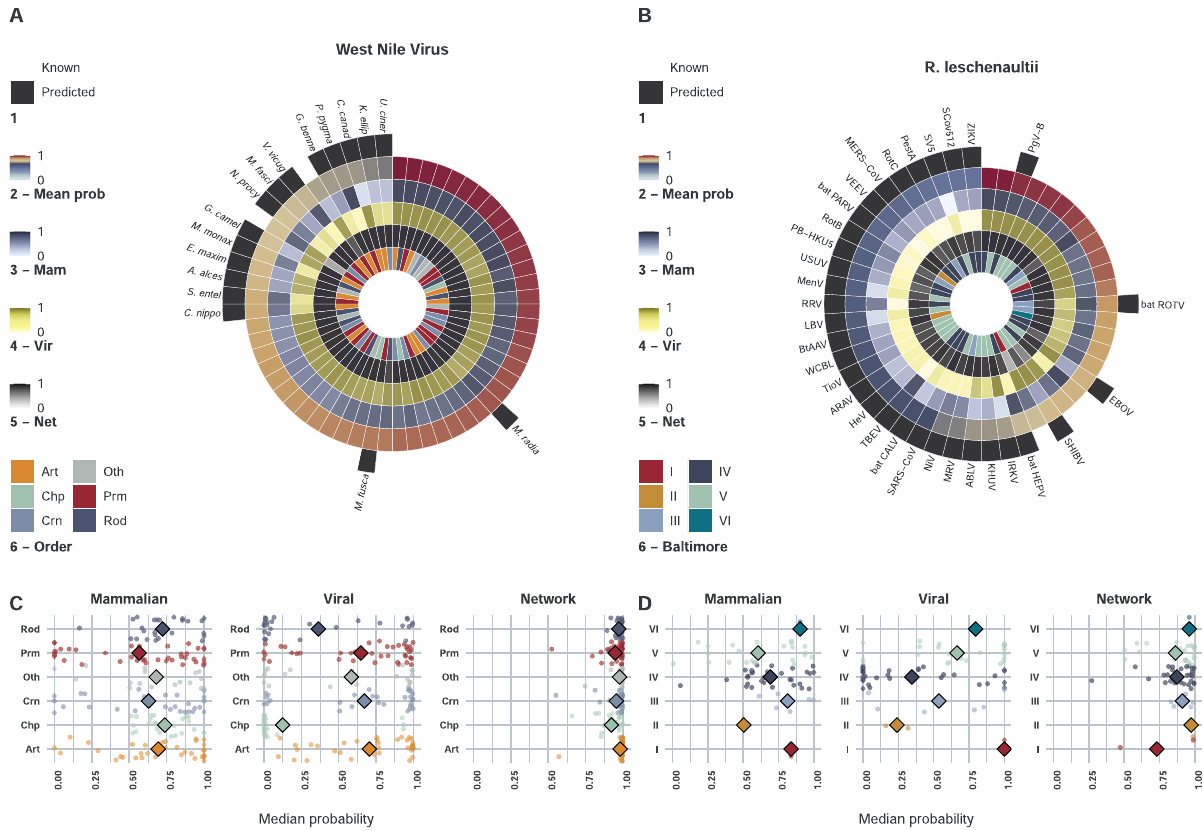
Fig. 1 Example showcasing fi nal and intermediate predictions of West Nile Virus (WNV), and Rousettus leschenaultii . Panel A Top 60 predicted mammalian species susceptible to WNV. Mammals were ordered by mean probability of predictions derived from mammalian (all models), viral (WNV models) and network perspectives, and top 60 were selected. Circles represent the following information in order: 1) whether the association is known (documented in our sources) or not (potential or undocumented). Hosts are omitted for known associations. 2) Mean probability of the three perspectives (per association). 3) Median mammalian perspective probabilities of predicted associations. These probabilities are obtained from 3000 models (50 replicate models for each mammal), trained with viral features – SMOTE class balancing. 4) Median viral perspective probabilities of predicted associations (50 WNV replicate models trained with mammalian features – SMOTE class balancing). 5) Median network perspective probabilities of predicted associations (100 replicate models, balanced under-sampling). 6) Taxonomic order of predicted susceptible species. Orders are shortened as follows: Artiodactyla (Art), Carnivora (Crn), Chiroptera (Chp), primates (Prm), Rodentia (Rod), and Others (Oth). Panel B Top 50 predicted viruses of R. leschenaultii . Viruses were ordered by mean probability of predictions derived from mammalian (R. leschenaultii models), viral (all models) and network perspectives. Circles as per Panel A . Baltimore represents Baltimore classi fi cation. Panel C Median probability of predicted WNV-mammal associations in each of the three perspectives per mammalian order. Points represent susceptible species predicted by voting (at least two of the three perspectives – n = 137). Median ensemble probability is computed in each perspective (50 replicate models for each virus/mammal, 100 replicate network models). Predictions derived from each perspective at 0.5 probability cut-off. Supplementary Data 1 presents full WNV results. Panel D Median probability of virus- R. leschenaultii associations in the three perspectives per Baltimore group. Points represent susceptible species predicted by voting (at least two of the three perspectives – n = 64), predictions are derived as per panel C . Supplementary Data 2 lists full results for R. leschenaultii. Supplementary Fig. 7 illustrate the results when research effort into viruses and mammals is included in mammalian and viral perspectives,